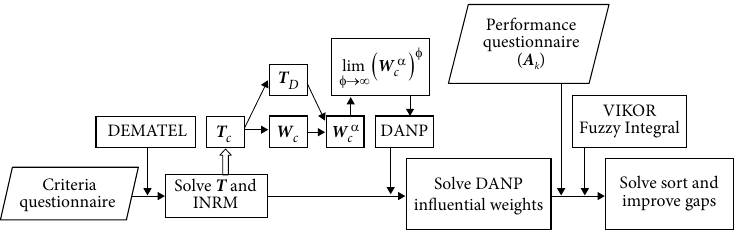
Fig. 2. Model procedures of Hybrid Dynamic Multiple Attribute Decision Making (HDMADM) (Chiu et al . 2013)